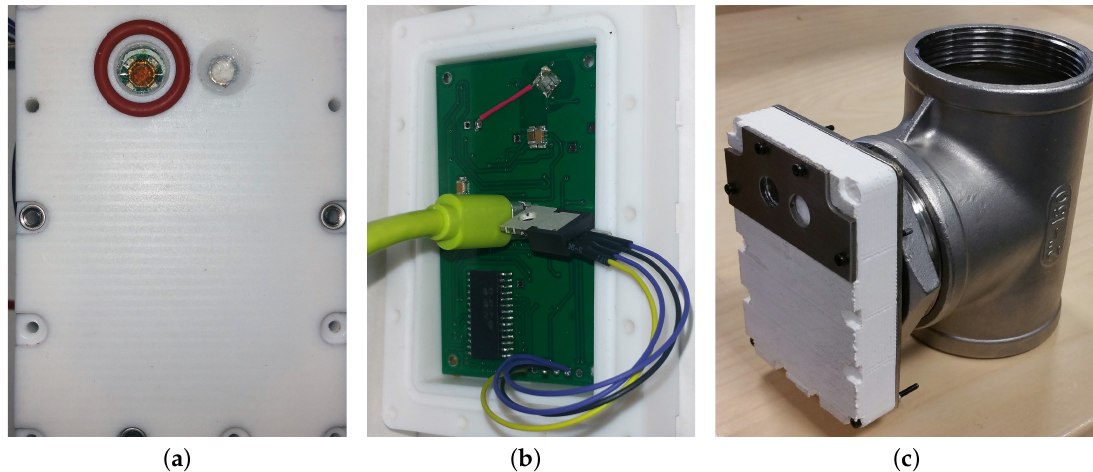
Figure 5. Sensor head prototype. ( a ) Front of the sensor with the photodiode window (with silicone gasket) on the left and pressure sensor on the right. ( b ) Back of the sensor without the stainless steel cover: printed circuit board (PCB) digitalization board (green), USB connection (light green) and wired temperature sensor are visible (TO220 package). ( c ) Sensor prototype on the tubular support. The sensor head size including the PTFE case and stainless steel flanges is: 87 × 61 × 20 mm 3